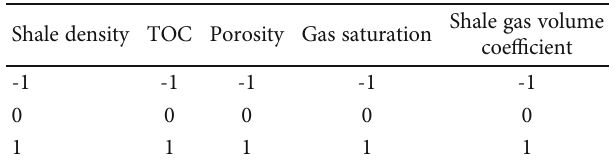
Table 1: Five factors and three levels orthogonal table.